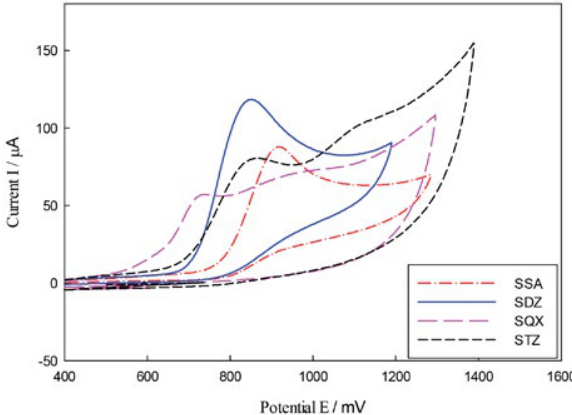
Figure 1. Electrochemical behavior of sulfacetamide (SAA), sul- fadiazine (SDZ), sulfaquinoxaline (SQX), and sulfathiazole (STZ) at